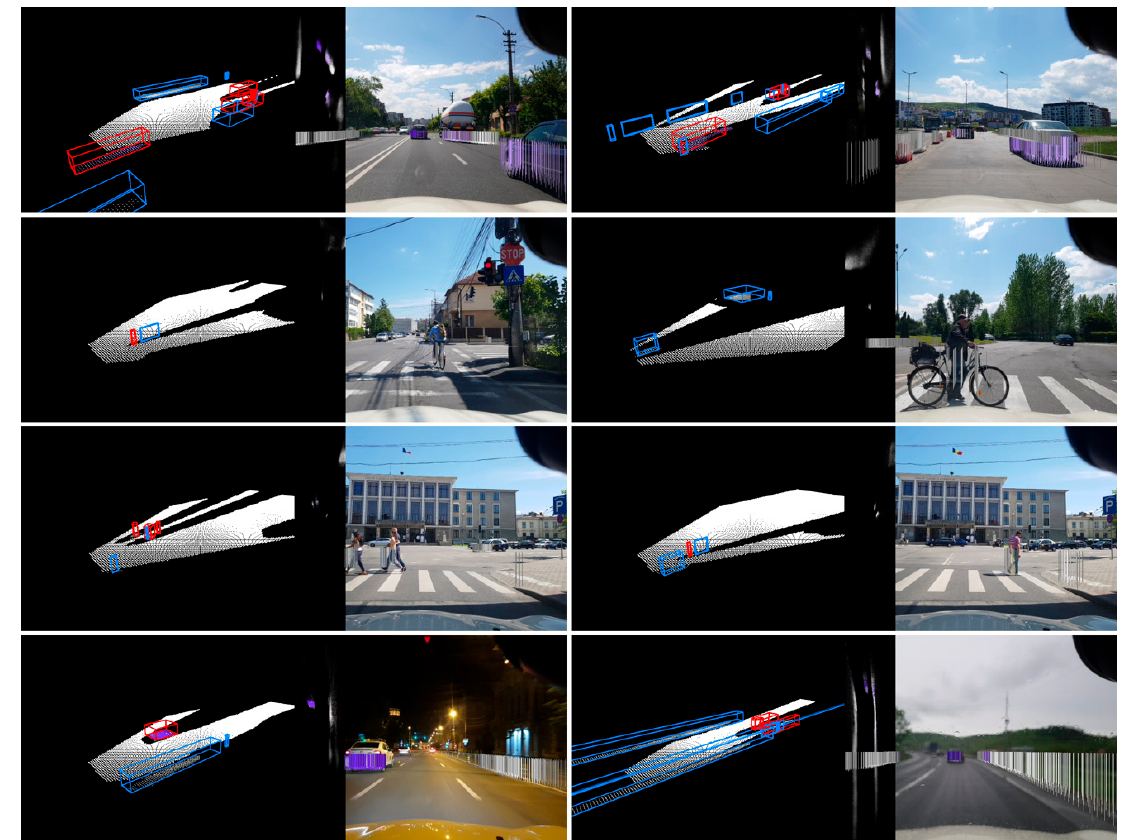
Figure 16. Eight examples with different scenarios from the processing system, each displaying the extracted cuboids and the segmented road surface (left), the color-coded particles in the top-down image view (center) and the particles projected in the color input image (right). Top row—detecting moving vehicles; second row—detecting bicycles; third row—detecting pedestrians; bottom row—detecting obstacles at night (left) or in the rain (right).